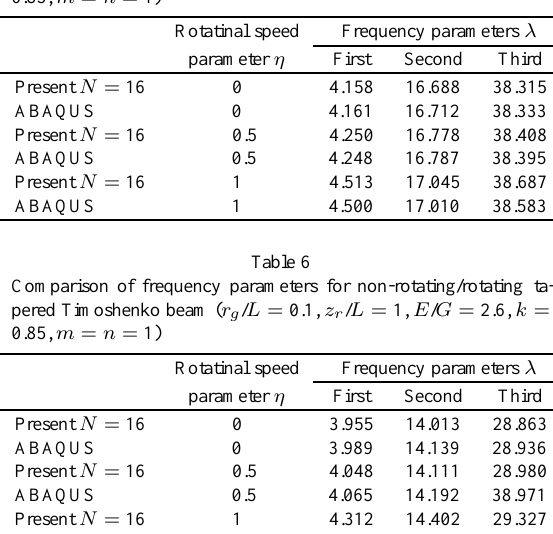
Table 5 Comparison of frequency parameters for non-rotating/rotating ta-